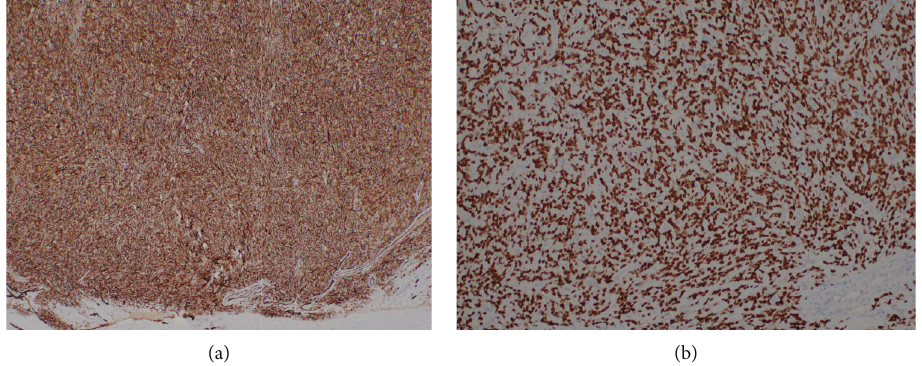
Figure 4: (a, b) The tumor cells showed strong and di ff use expression of CD34 ((a) 100x) and STAT6 ((b)